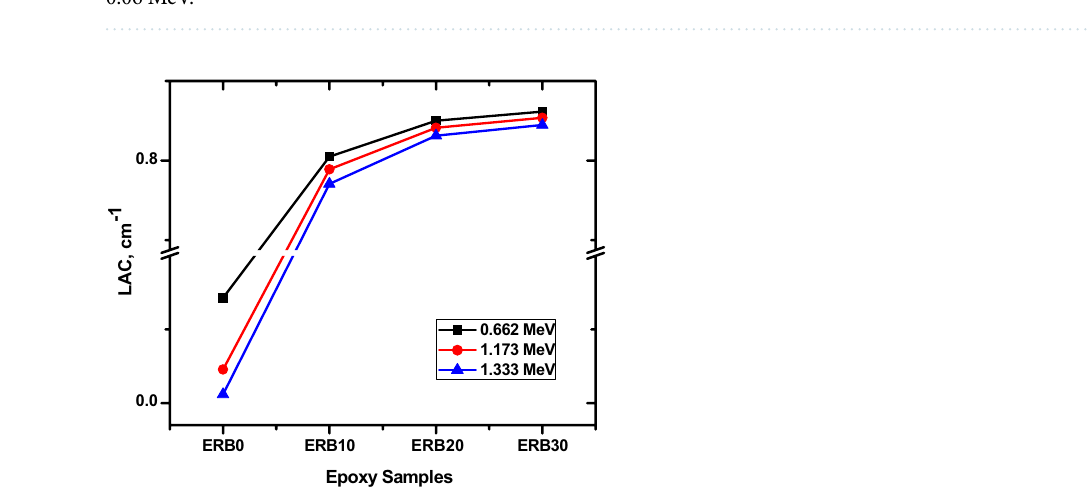
Figure 5. The relation between the linear attenuation coefficient and the density of the prepared composites at 0.06 MeV.